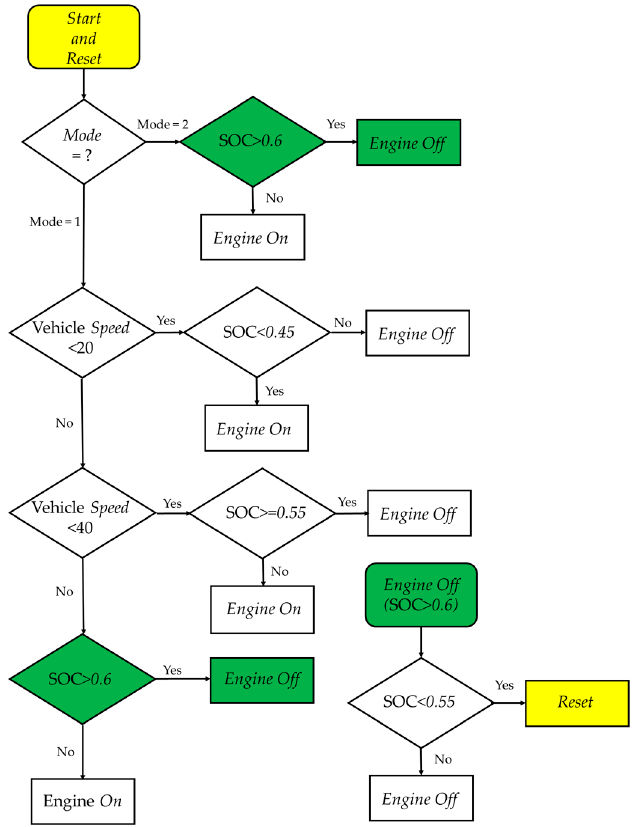
Figure 10. Engine switch flowchart.